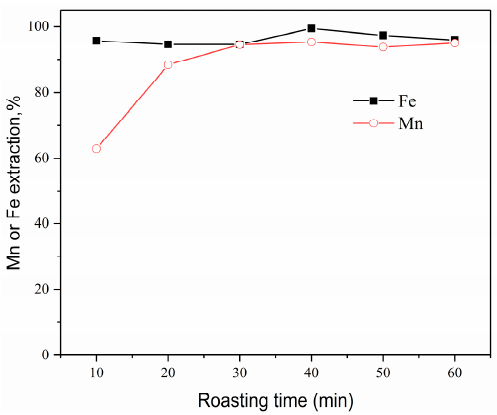
Figure 7. The effect of roasting time on the extraction of iron and manganese from PAR.